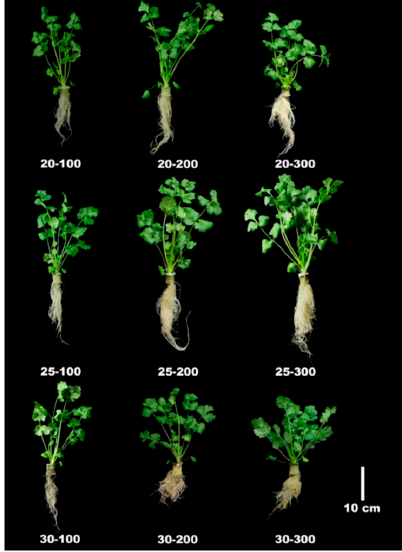
Figure 1. Coriander plants grown under nine different treatments with a combination of photosynthetic photon flux density and root-zone temperature for 19 days after transplanting. The codes below the plants show each treatment: 20, 25 or 30 for 20, 25 or 30 °C in root-zone temperature, respectively; 100, 200 or 300 for 100, 200 or 300 µmol m − 2 s − 1 in photosynthetic photon flux density, respectively.